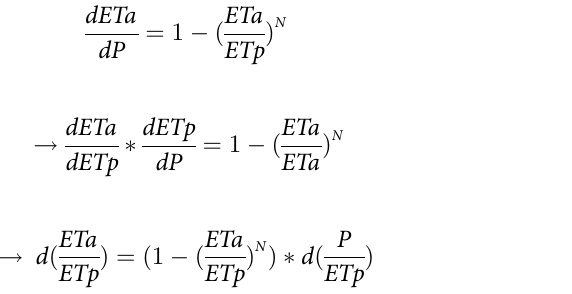
The Bagrov model can be applied to calculate the actual evapotranspiration. Bagrov first attempted to derive the analytical equation for the mean annual water-energy balance [39]. He analyzed the data on water balances and derived the Bagrov equation, in which evapotranspira- tion depended on the precipitation and potential evapotranspiration. The equation considered both water limiting and energy limiting for actual evapotranspiration [40]. In the case of arid conditions, water availability dominates evapotranspiration, and in the opposite condition, energy availability is crucial [41]. Thus, actual evapotranspiration is strongly limited by either water or energy availability. The functional relationship between the evapotranspiration effi- ciency (ETa/ETp) and the potential humidity (P/ETp) is given by the Bagrov equation (Eq 1) [42]. The equation directly reflects the Ea changes’ responses to precipitation and ETp changes.